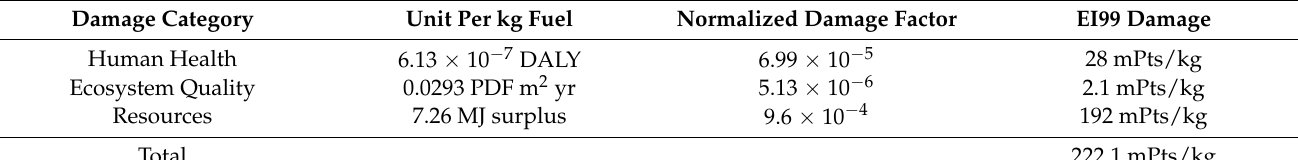
Table 2. Environmental impacts of the consumed natural